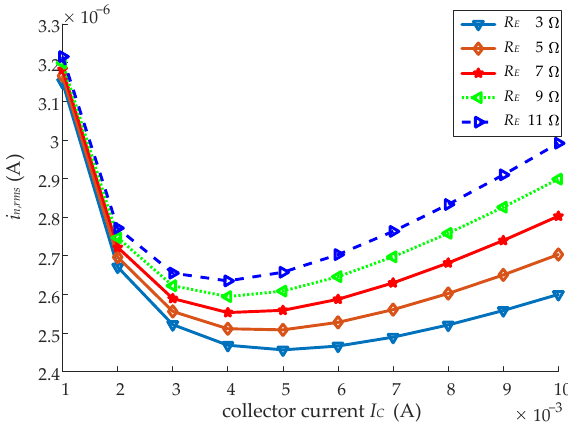
Figure 4. The noise optimization results of the input TIA.